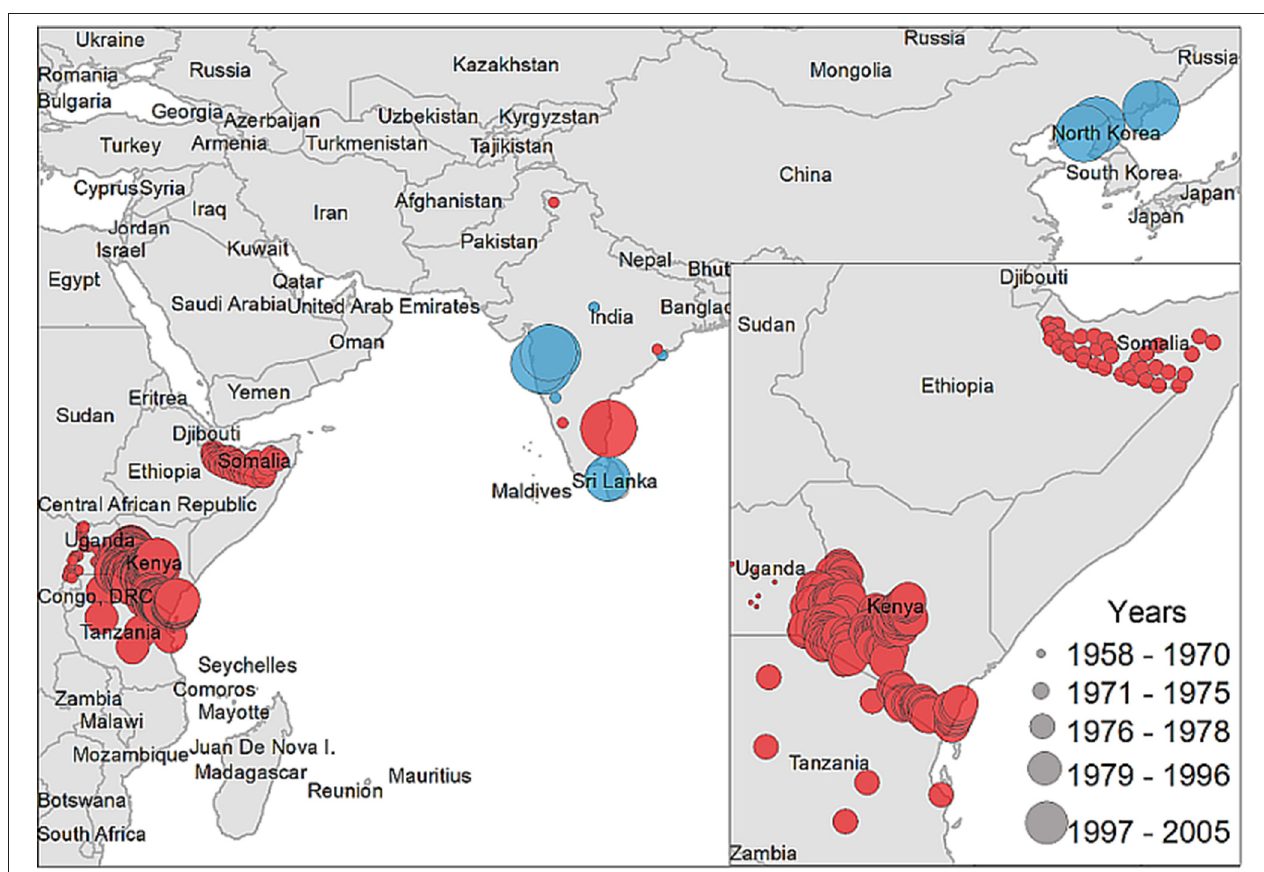
FIGURE 3 | Case distribution of NSDv used for model calibration. Points denote occurrence locations. Color represents positive host (red) and tick (blue) occurrences and size denotes the year of publication.